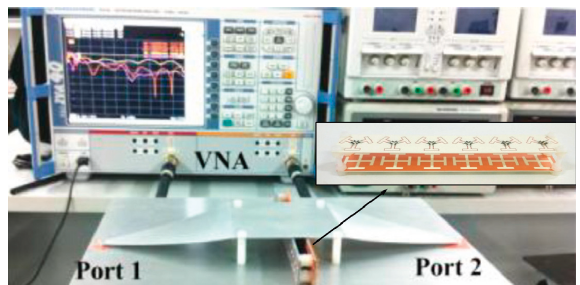
Figure 10: Photograph of the measurement setup in a TEM